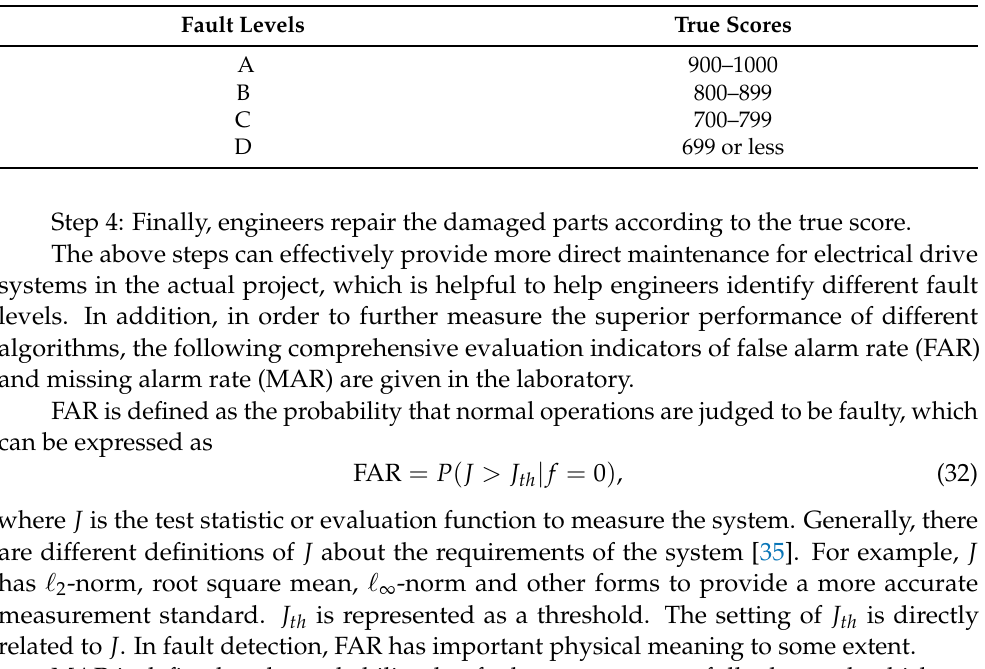
Table 3. Fault level results of electrical drive